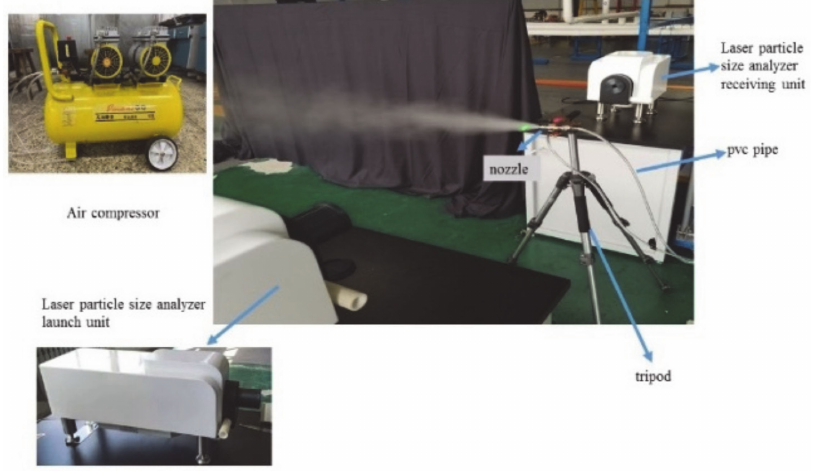
Figure 7. Experimental platform for atomization